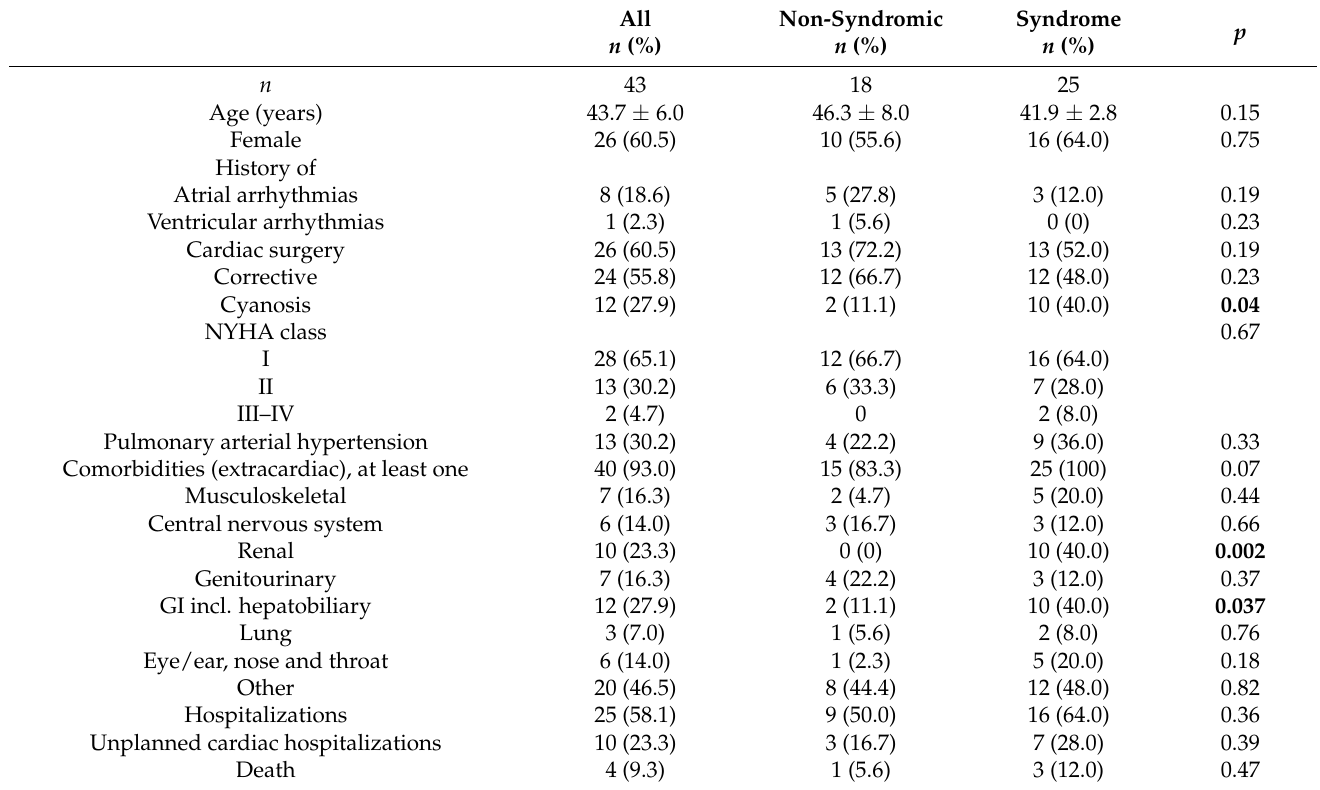
Table 1. Baseline characteristics with a comparison between patients with and without syndrome.